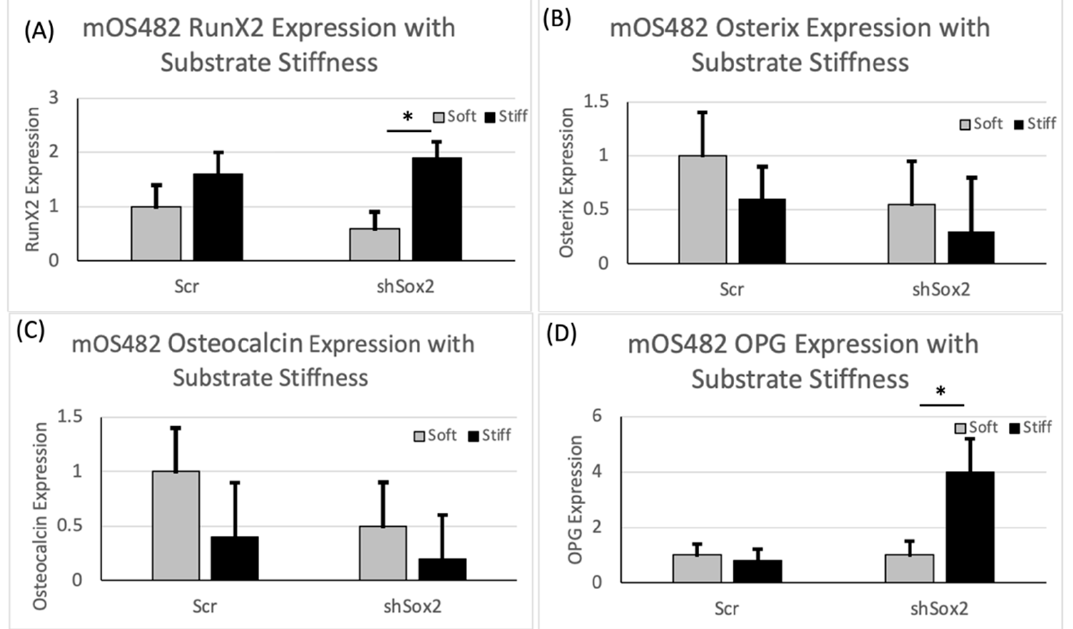
Figure 6. Evaluation of osteogenic gene expression in scr and shSox2 cells as a function of substrate stiffness. Quantification of ( A ) Runx2 ( B ) Osterix ( C ) Osteocalcin and ( D ) OPG expression in scr and shShox2 cells with substrate stiffness. * p < 0.01; p value from Mann–Whitney test for statistical significance.